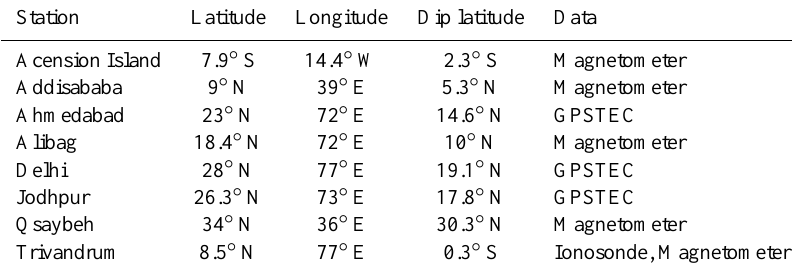
Table 1. Table depicting the location information and the type of data used at each location.